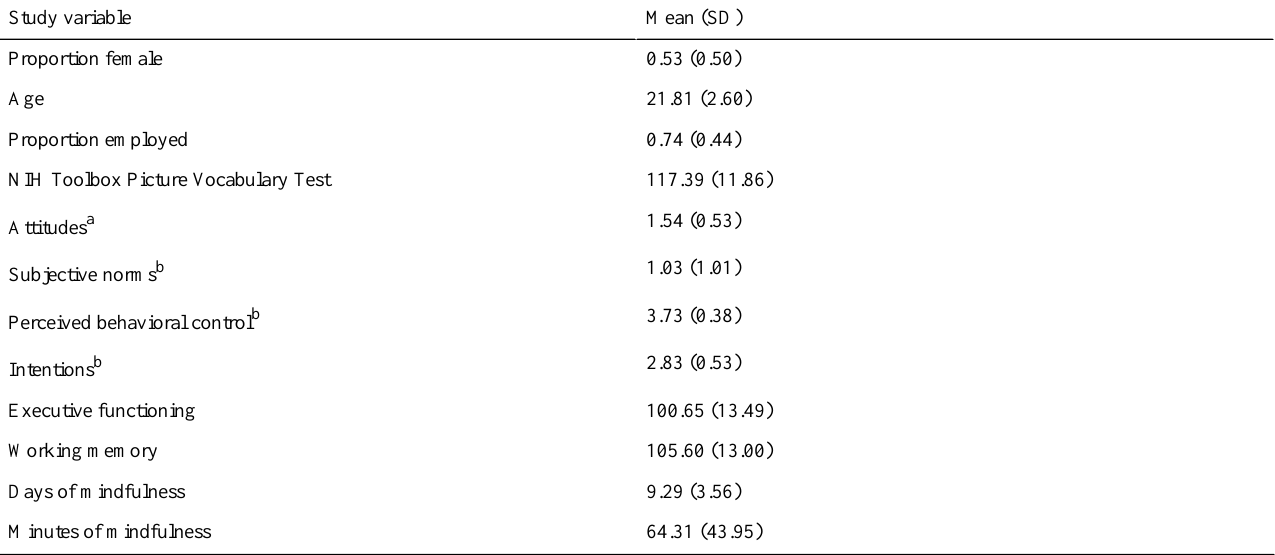
Table 2. Descriptive statistics of demographic and key study variables (N=85).